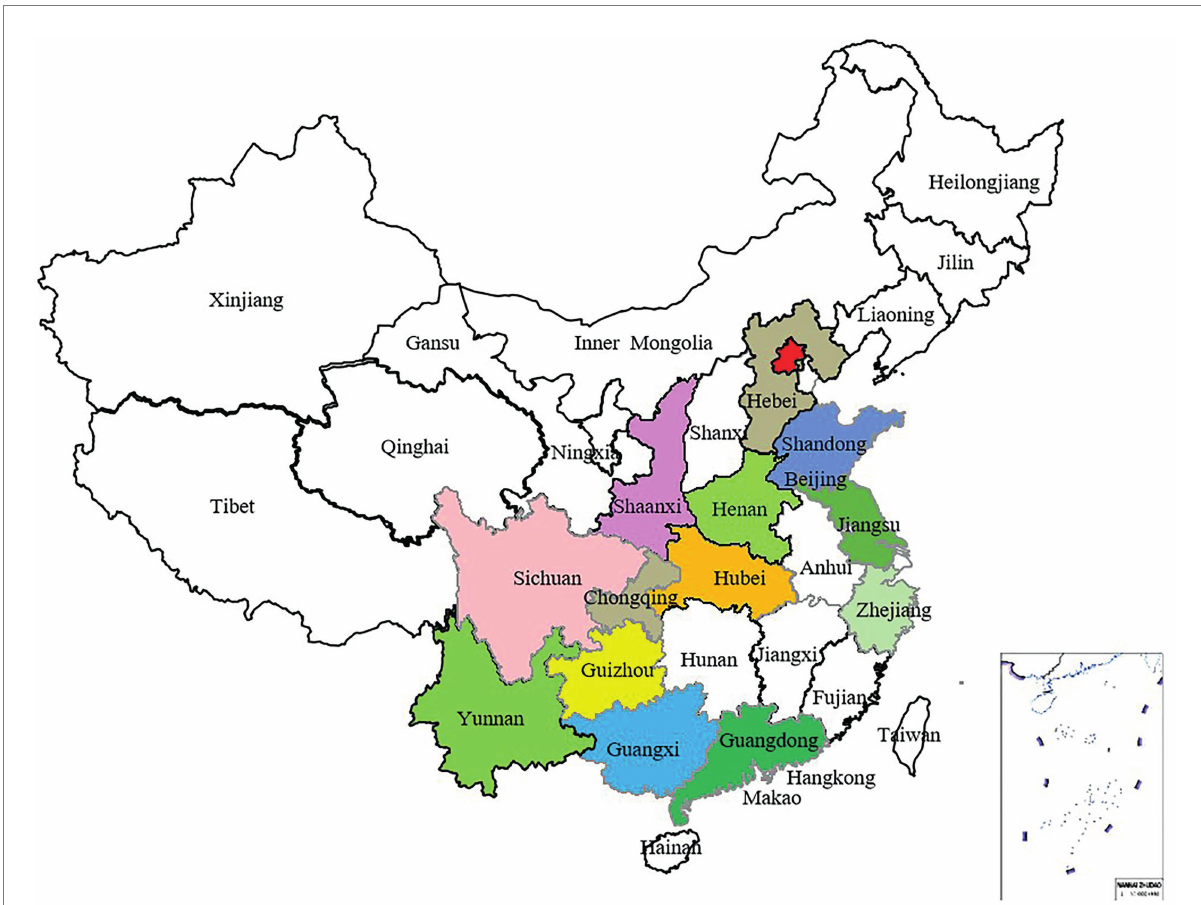
FIGURE 2 Distribution map of 186 Venturia carpophila isolates, which were collected from 14 major peach-producing provinces in